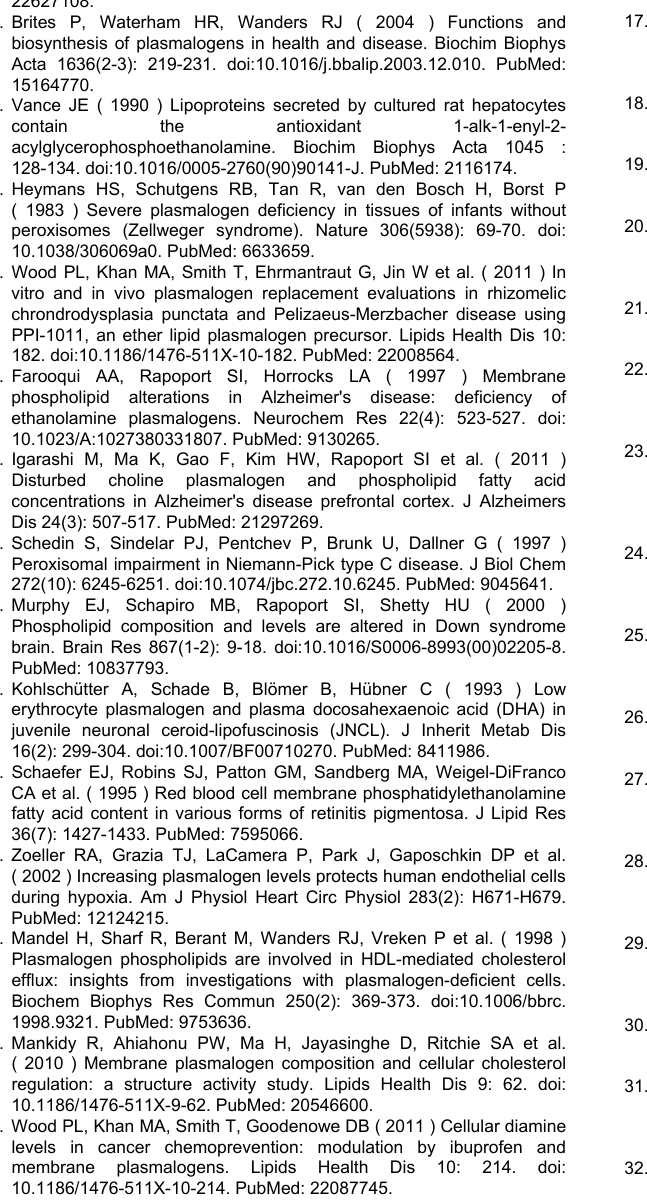
at 490nm was measured with a multiscan plate reader. Data are presented as the mean±S.D.